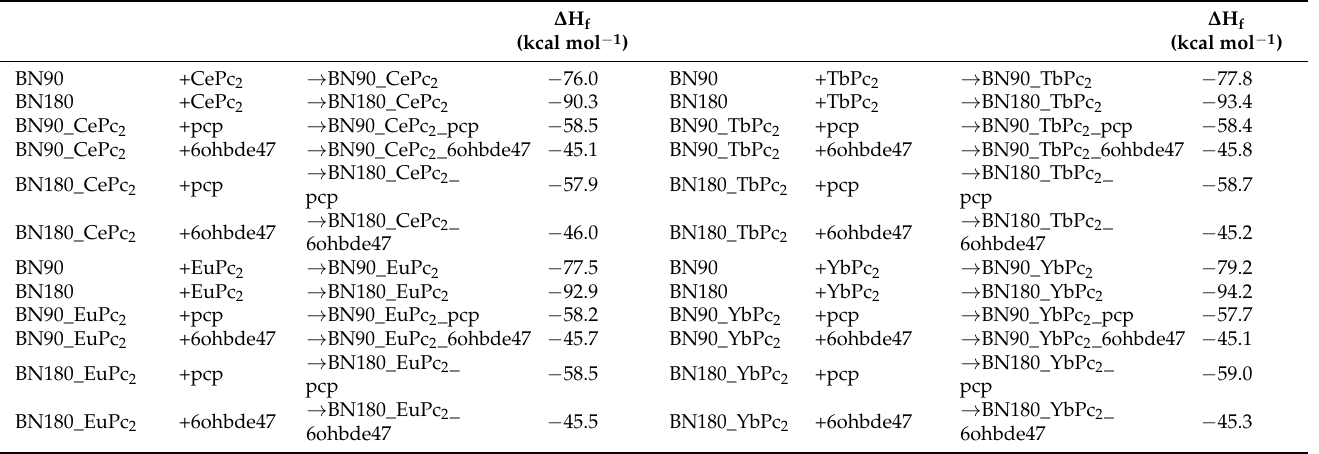
Table 1. Reaction enthalpy ( ∆ H f in kcal/mol) of pentachlorophenol (pcp)/6-OH-BDE-47 (6ohbde47) adsorbed by the zigzag (9,0) and (18,0) boron nitride nanotubes decorated with CePc 2 , EuPc 2 , TbPc 2 , and YbPc 2